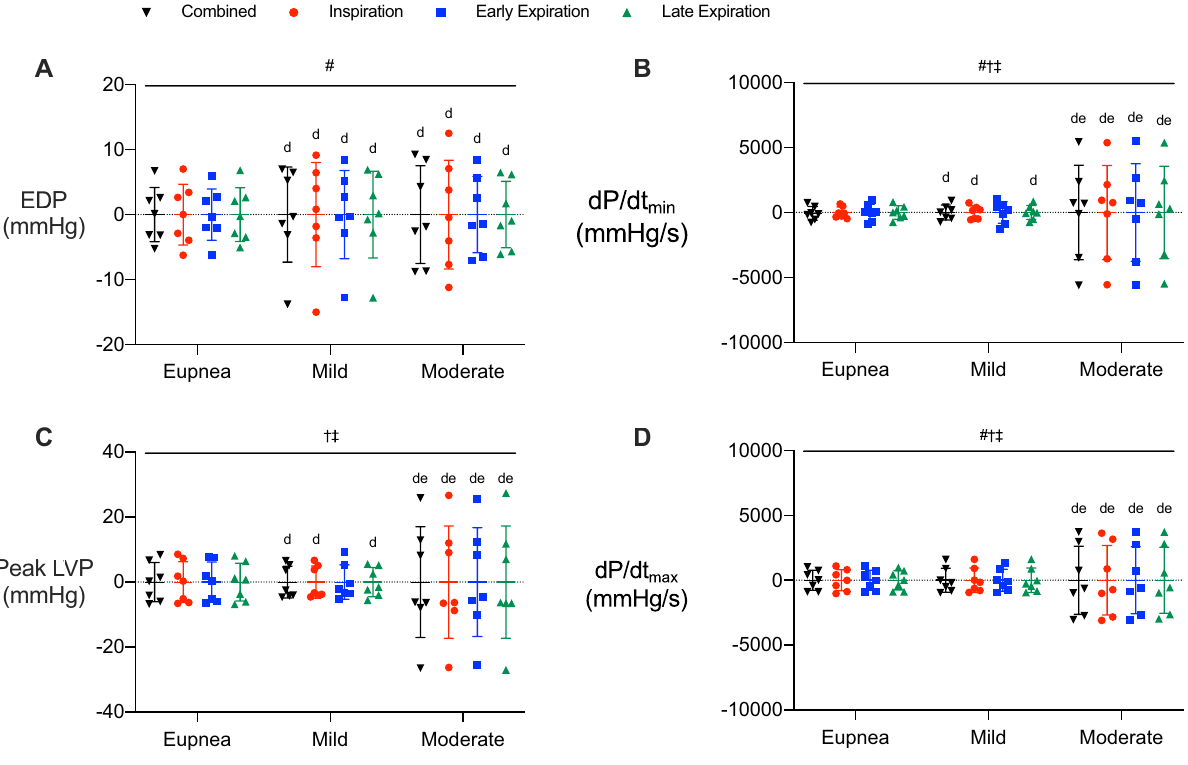
Figure 5. Respiratory resistance loading increases variance in cardiac parameters. Group means were subtracted from individual data points to set all means equal to zero and observe variance in each group. Parameters are shown prior to separating by respiratory phase (black; combined) and during inspiratory (red), early expiratory (blue), and late expiratory (green) phases with eupneic breathing and mild and moderate resistance loads. ( A ) End diastolic pressure. ( B ) dP/dt min . ( C ) Peak left ventricle pressure. ( D ) dP/dt max . Data are presented as ± SD. #, significant interaction; †, main effect of respiratory load; ‡, main effect of respiratory phase; d, different from eupnea within a respiratory phase; e, different from mild resistance within a respiratory phase; p > 0.05 for all. All data were analyzed using a within-subject two-way ANOVA. Where Mauchly’s test